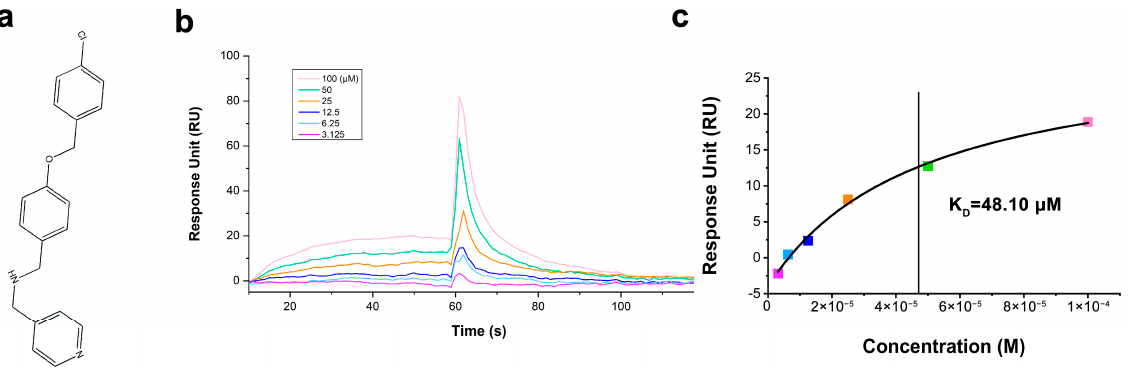
Figure 2. The binding affinity of the compound CBPA with hPD-L1 was measured with SPR. ( a ) The chemical structure of CBPA. ( b ) Overlay of sensorgrams for the interactions between hPD-L1 and CBPA. ( c ) Response data at equilibrium versus CBPA concentration.